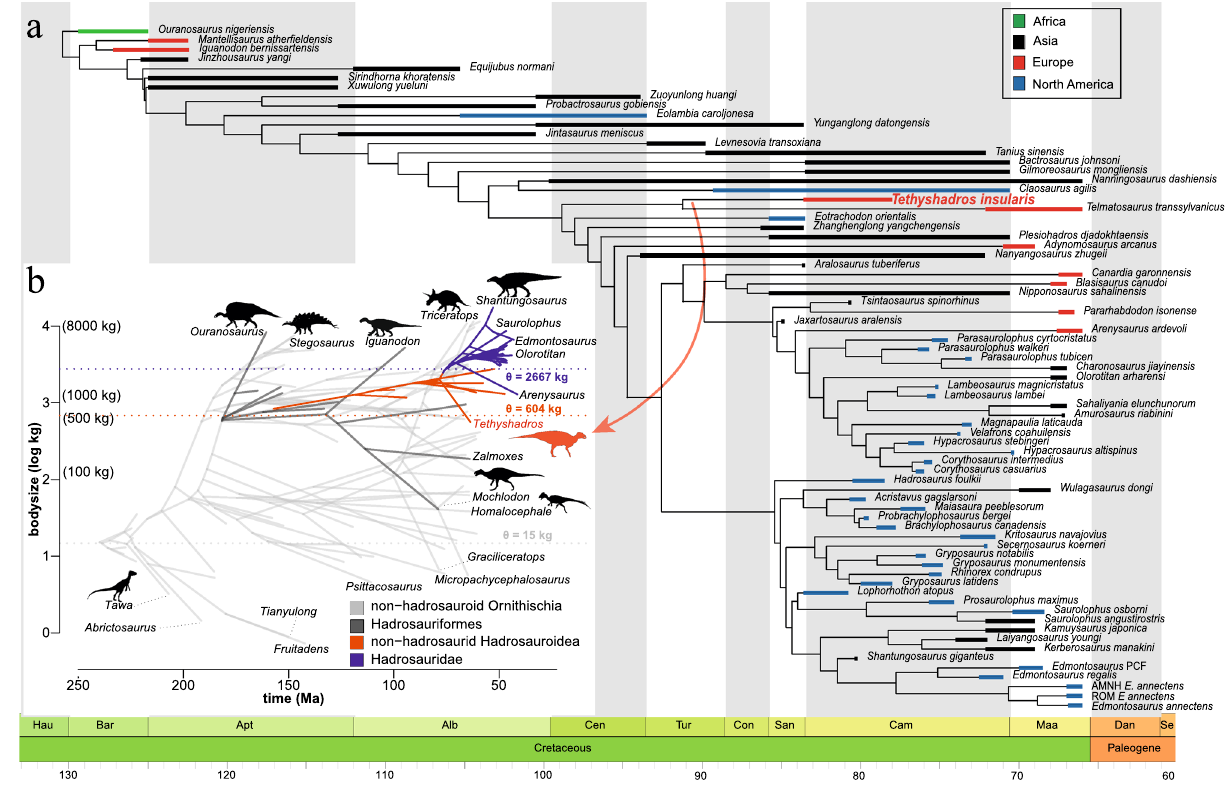
Figure 4. Phylogenetic systematics of Tethysahdros insularis showing the biogeographic position of each taxon in the Phylogeny of Hadrosauriformes ( a ). An evolutionary phenogram ( b ) fitting the best OU model (see “Materials and methods”) for the evolution of body size in Ornithischia is also included, highlighting the body- size optima characterizing non-hadrosaurid hadrosauroids (orange), including Tethyshadros (red silhouette) and Hadrosauridae (blue). Symbols and abbreviations: θ, optimal body-size; Ma, Mega-annum (million years ago). While data on the y-axis are log scaled, bracketed values represent their equivalent in kg.